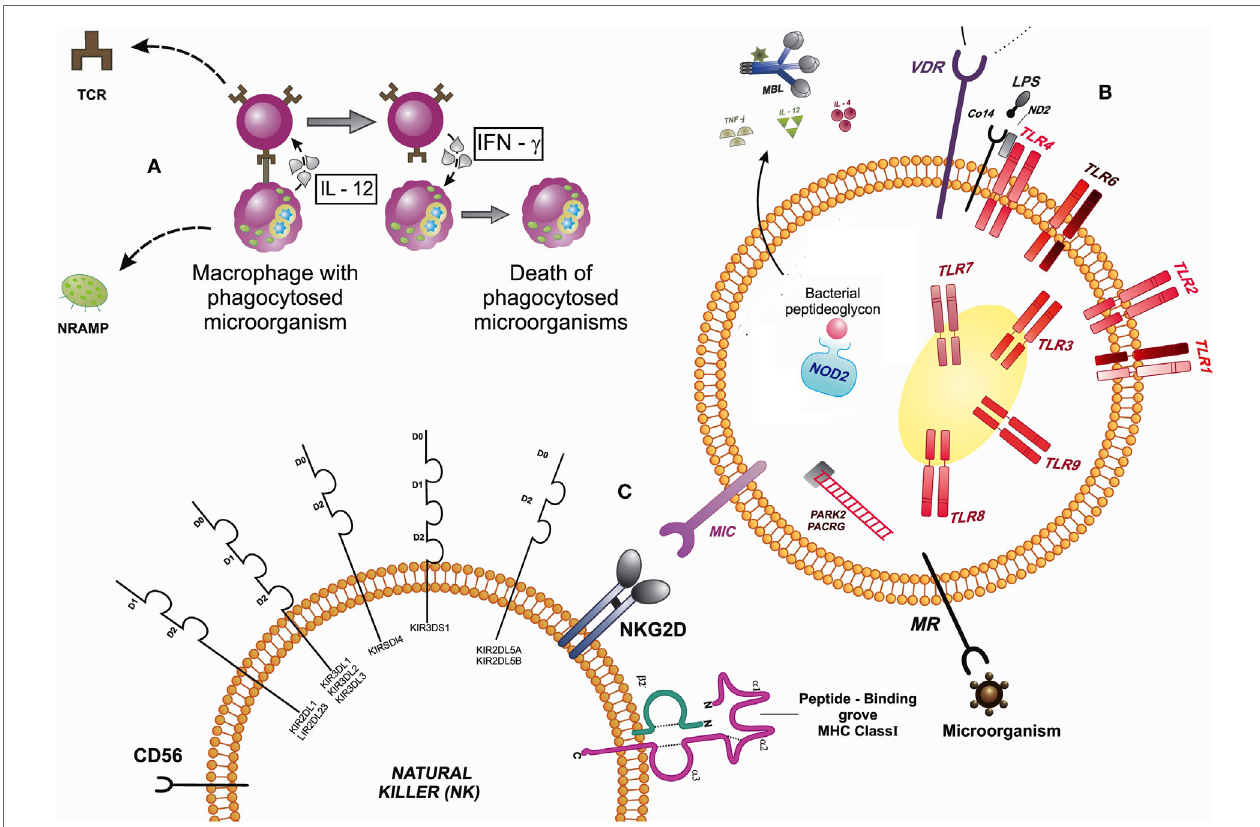
FiGURe 2 | Signaling between cells that participate in the innate immune response by expressing receptors that interact in the presence of a microorganism. (A) Macrophages are phagocytic cells that internalize microorganisms and presented to T cells (TCR). T cells, in turn, release IFN- γ that may activate other immune system cells. The NRAMP1 gene is encoded inside the macrophages, lysosomal membrane proteins that assist in the process of phagocytosis, acting on ion transport. (B) The immune cells have cell surface receptors that can promote a downstream signaling: TLRs, VDR, MRC, and NOD-2 (modulate the autophagy). MIC, which are proteins that are induced into a state of cellular stress, can be recognized by the NKG2D receptor on the surface of T γδ lymphocytes, CD8 + αβ T lymphocytes, and natural killer cells (NK) that contribute to defend the body against infections. The PARK2 acts in the coding process of E3 ubiquitinase necessary signaling cascade in certain cellular processes, such as NOD2, requiring E3 ubiquitin in NF- κ B activation process. (C) NK cells recognize MIC expressed in infected cells by NKG2D receptor. Abbreviations: TLR, toll-like receptors; MRC, mannose receptor of the C-type lectin; NOD2, nucleotide-binding oligomerization domain 2 protein, human; MBL, mannose-binding lectin; PACRG/PARK2, PACRG protein, human/PARK2-coregulated protein, human; MIC, major histocompatibility complex class I chain-related genes; KIR, killer cell immunoglobulin-like receptors; IL, interleukins; TNF, tumor necrosis factor; IFN, interferons; MHC, major histocompatibility complex; NKG2D, killer cell lectin-like receptor subfamily K; protein; NRAMP, natural resistance-associated macrophage protein; TCR, T-cell receptor; MR, mannose receptor; VDR, vitamin D receptor; LPS, lipopolysaccharide; MD2, myeloid differentiation protein-2,